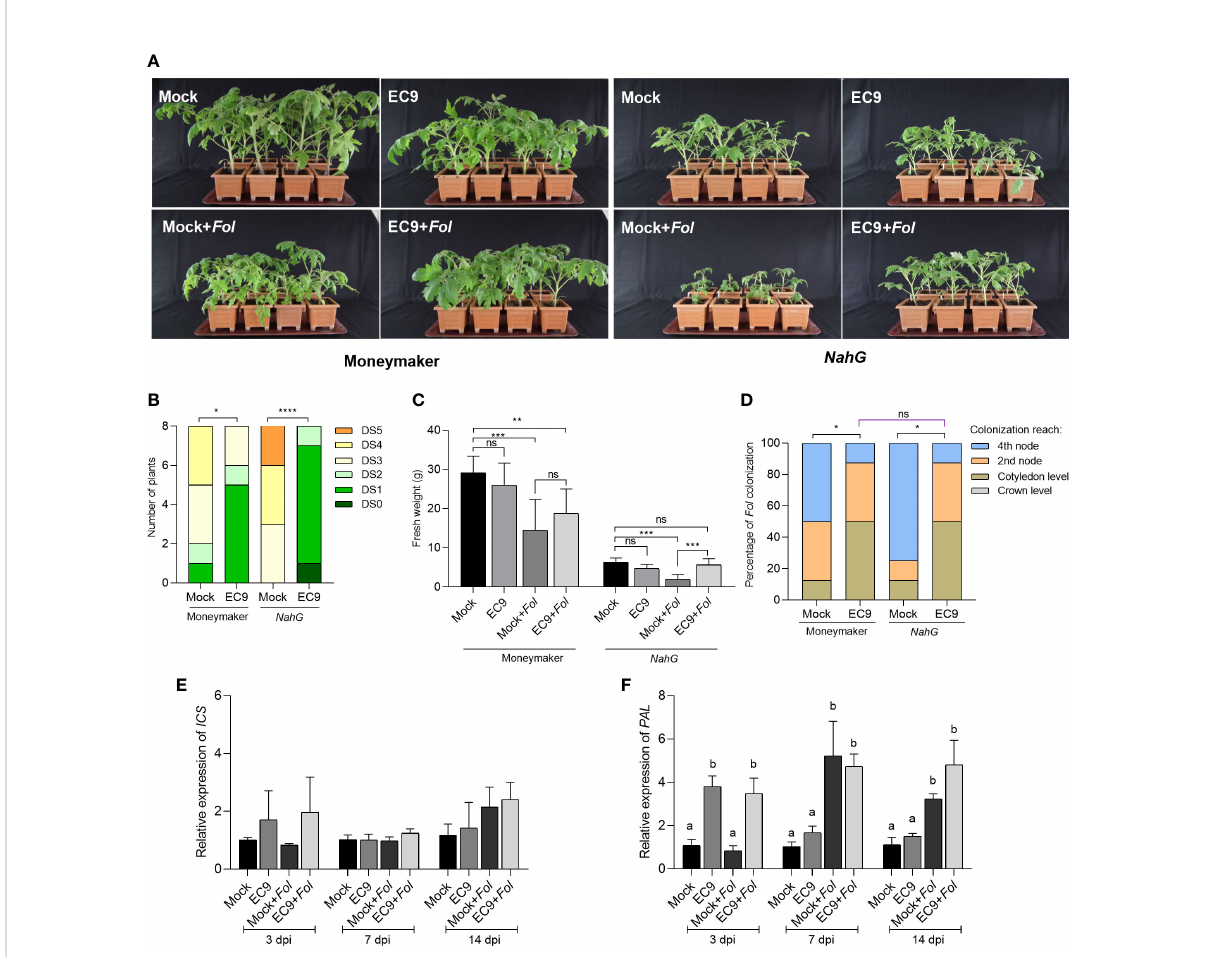
FIGURE 2 The SA signaling pathway is not involved in EC9-enhanced defense in tomato. (A) Disease symptoms, (B) disease severity score and (C) fresh weight of transgenic NahG plants and the corresponding wild type cv. Moneymaker at 21 days post-inoculation (dpi) (n=8). Ten-days old tomato seedlings were treated with EC9 or 10 mM MgCl 2 (mock) by soil drenching and inoculated with Fol 1 week after treatment. (D) Percentage of Fol infected stem sections at 21 dpi (n=8). ns non-signi fi cant, * P < 0.05, ** P < 0.01, *** P < 0.001, **** P <0.0001. The accumulation of transcripts of (E) isochorismate synthase ( ICS ) and (F) phenylalanine ammonia-lyase ( PAL ) in tomato plants (cv. Moneymaker) treated with EC9 or mock and inoculated with Fol was revealed by qRT-PCR (n=3). For gene expression analysis, stem pieces from the region between cotyledons and crown were harvested. The values were normalized to the internal reference transcript a -tubulin. Bars represent the means of the indicated number of biological replicates ± standard error. The experiments were repeated at least two times with similar results. Different letters indicate statistically signi fi cant differences between